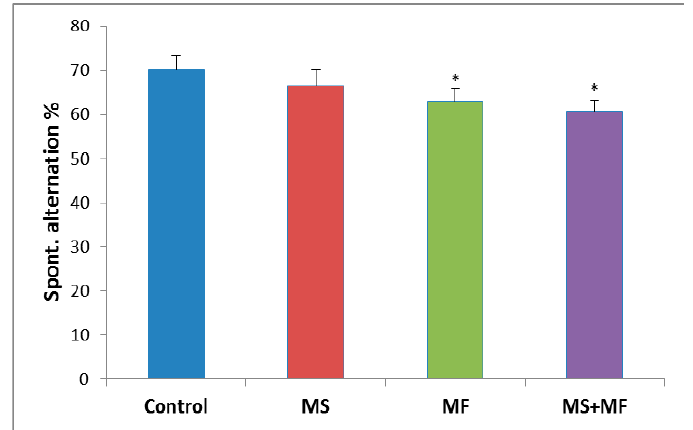
Figure 3. The effects of various combinations of stress factors in the Y-maze test, as showed by the spontaneous alternation parameter. The values are mean ± S.E.M ( n = 10 per group, * p < 0.05 vs. control, MS = maternal separation, MF = multifactorial stress.